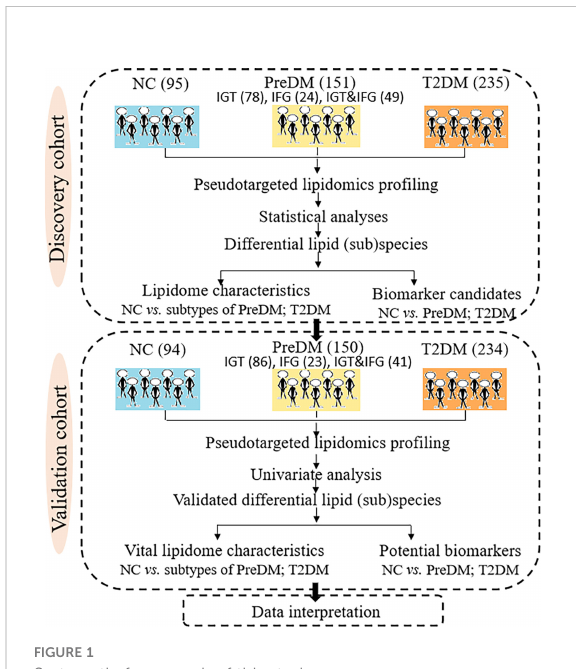
FIGURE 1 Systematic framework of this